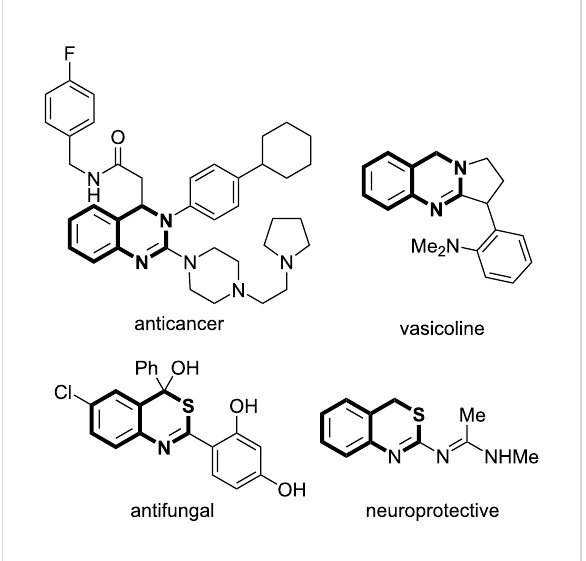
Figure 1: Some bioactive 3,4-dihydroquinazolines and 4 H -3,1-